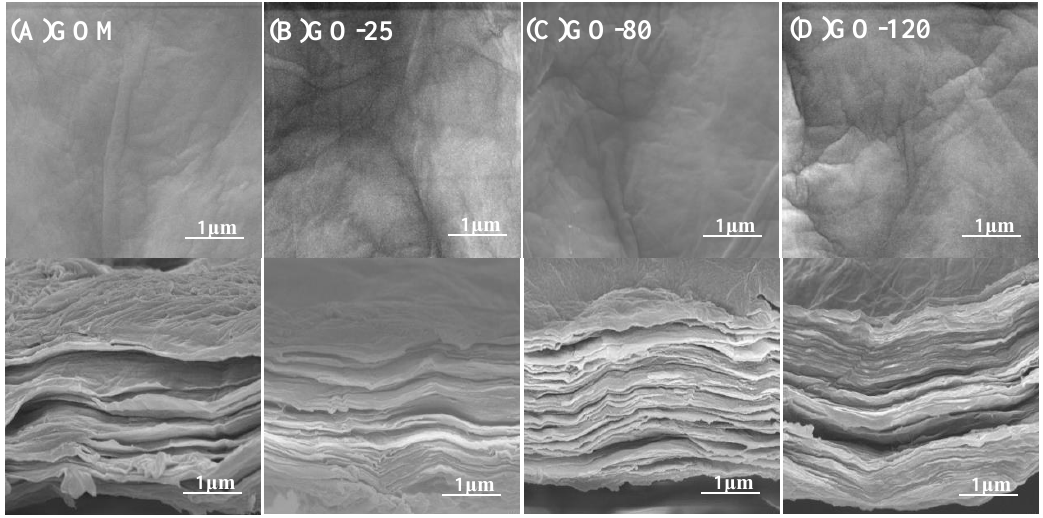
Figure 1. SEM surface and cross-section images of ( A ) GOM, ( B ) GO-25, ( C ) GO-80, ( D ) GO-120.